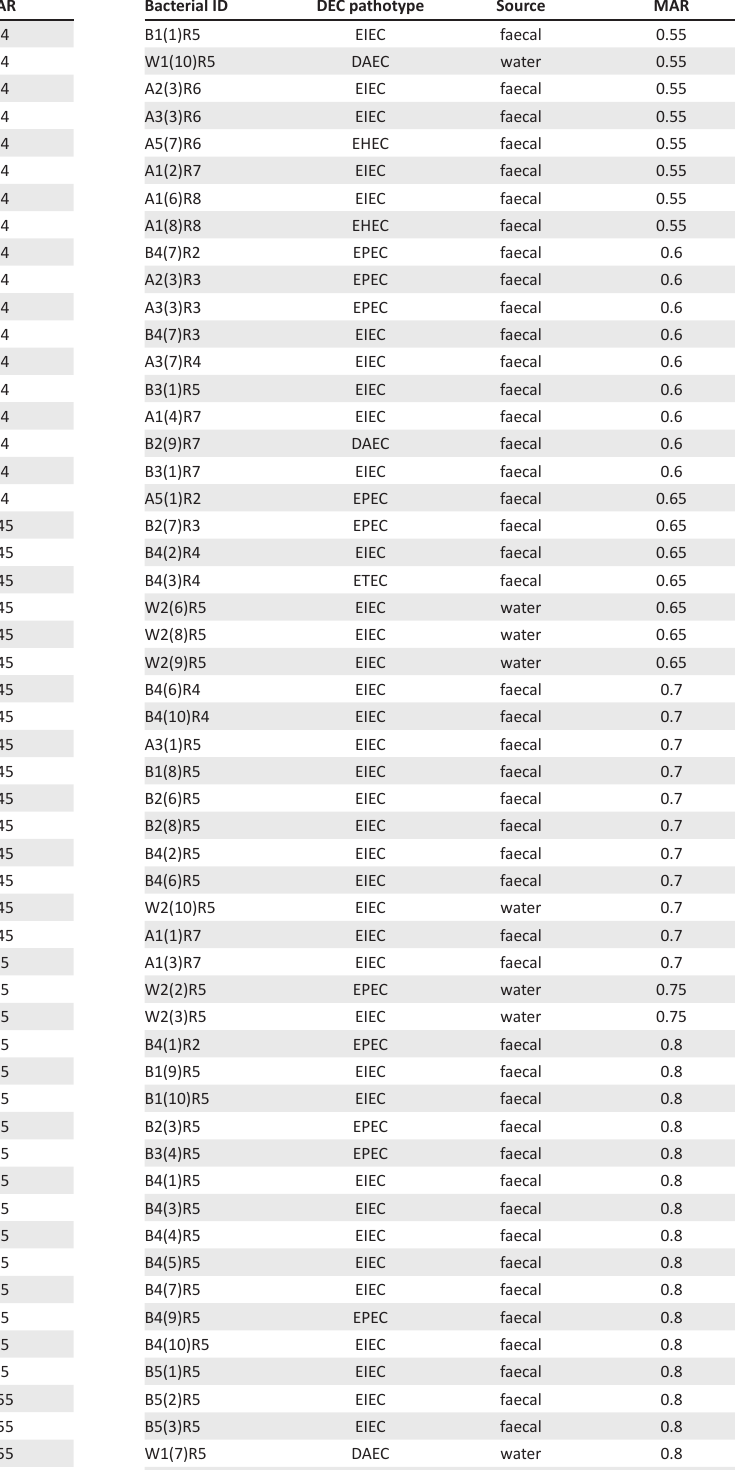
TABLE 4-A1 (Continues...): Multiple-antibiotic resistance index for all diarrheagenic E. coli pathotypes along the farm-to-fork continuum. Bacterial ID DEC pathotype